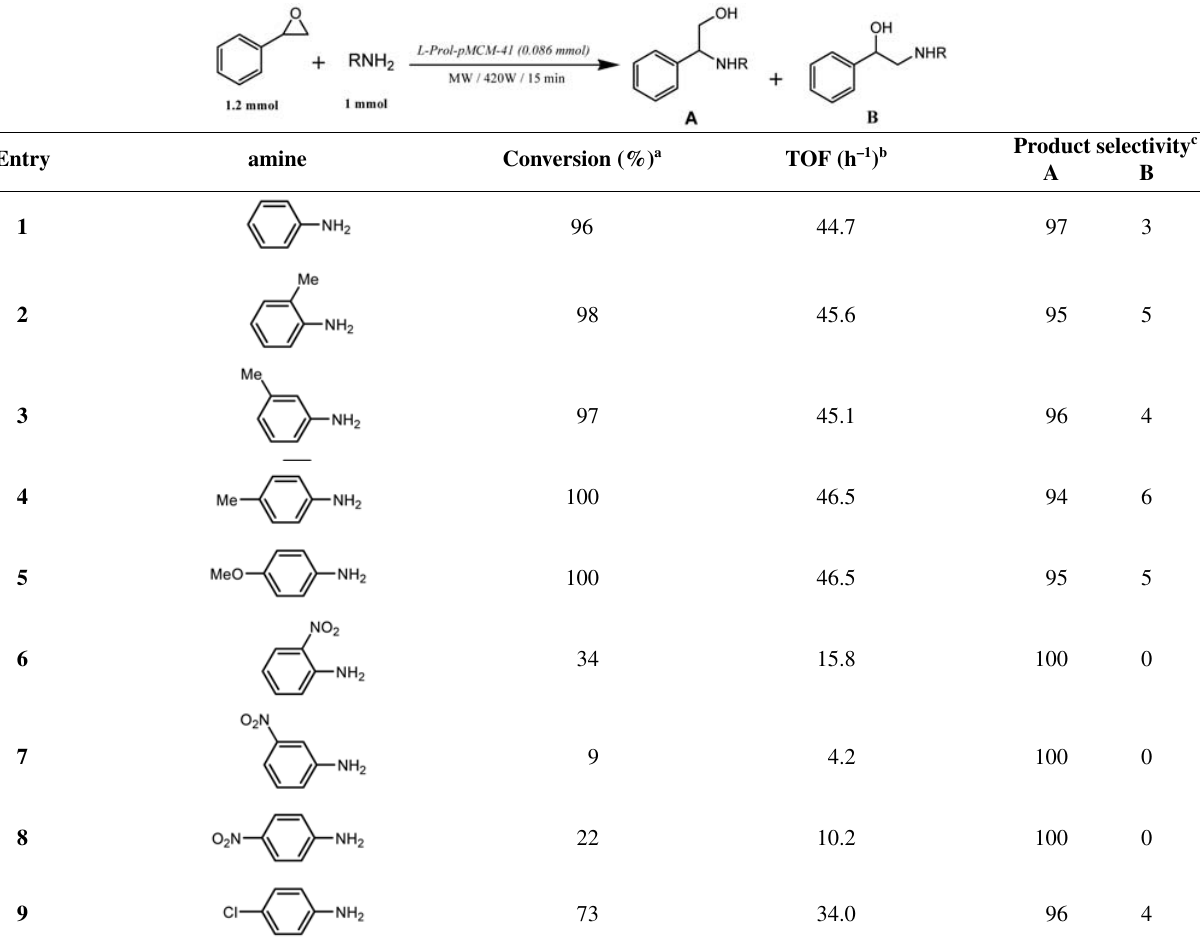
Entry amine Conversion (%) a TOF (h –1 )